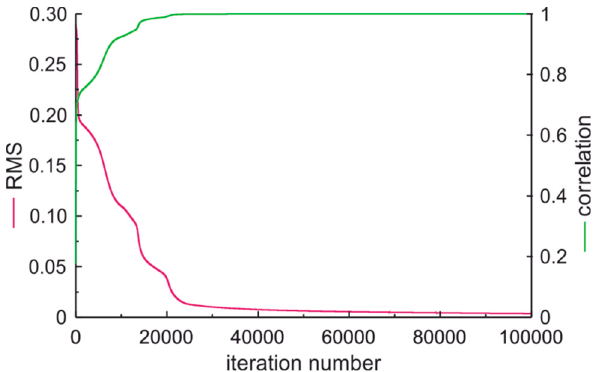
Figure 14. The artificial neural network (ANN) learning process of fuel quality type classification.